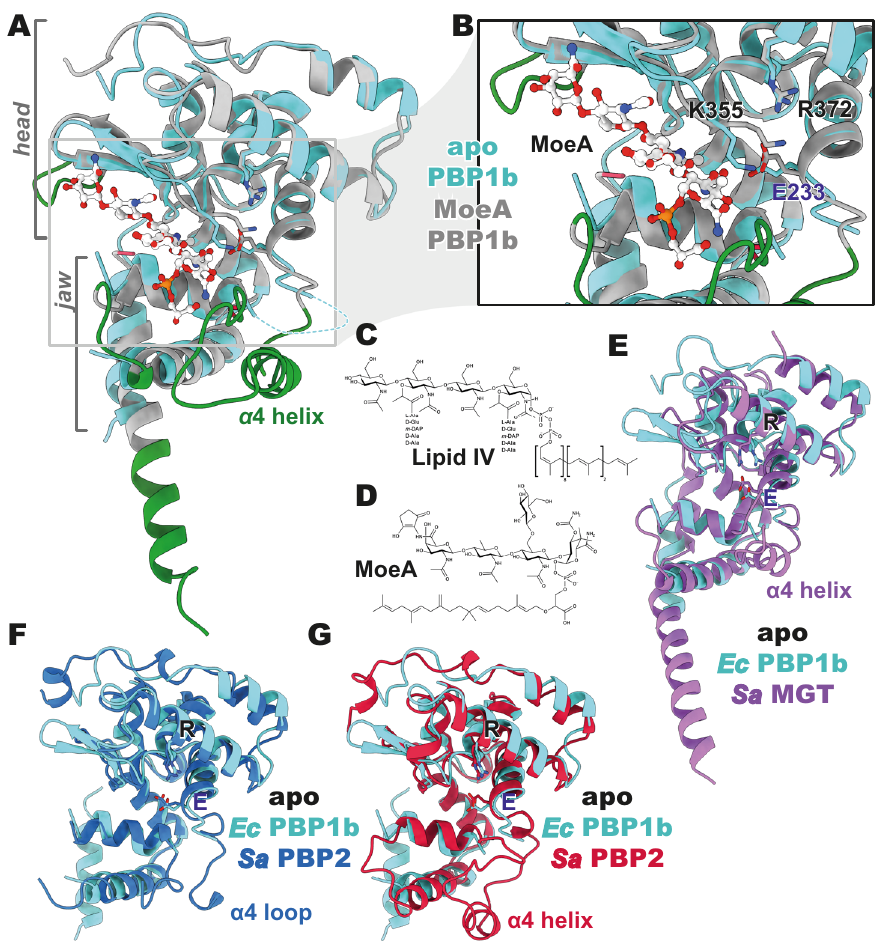
Fig. 4 Glycosyltransferase domain of apo PBP1b. A An overlay of the GTase domains of the apo structure of E. coli PBP1b- (cyan) and a moenomycin A- (MoeA) bound crystal structure (grey — PDB 5HLB 3 ). Regions resolved in the MoeA-bound crystal structure are coloured in green. Notably, a lack of stabilization by MoeA leads to the unresolved nature of the α 4 helix loop in the apo PBP1b structure. Both the head and jaw regions are labelled in grey. B A view of the active site of the GTase domains, as in ( A ), highlighting the relatively conserved nature of the active site. The catalytic general base, E233, is labelled in blue font, while the K355 and R372, which modulate the p K a of the E233 carboxylate side chain, are labelled in black. C , D A comparison of lipid IV, a substrate of the GTase domain ( C ) and moenomycin A (MoeA), a lipid IV substrate analogue inhibitor ( D ). E – G A comparison of the apo E. coli PBP1b GTase domain structure (cyan) to the three published crystal structures of apo GTase domains. Conserved glutamate general base and p K a -modulating arginine are shown and labelled in blue and black, respectively. E Apo E. coli PBP1b GTase domain compared to the apo structure of the monofunctional GTase, MGT, of S. aureus (purple — PDB 3VMQ 17 ). F Apo E. coli PBP1b GTase domain compared to the fi rst apo structure of the bifunctional PBP, PBP2, of S. aureus (blue — PDB 2OLU 6 ). G Apo E. coli PBP1b GTase domain compared to the second apo structure of the bifunctional PBP, PBP2, of S. aureus (red — PDB 3DWK 5